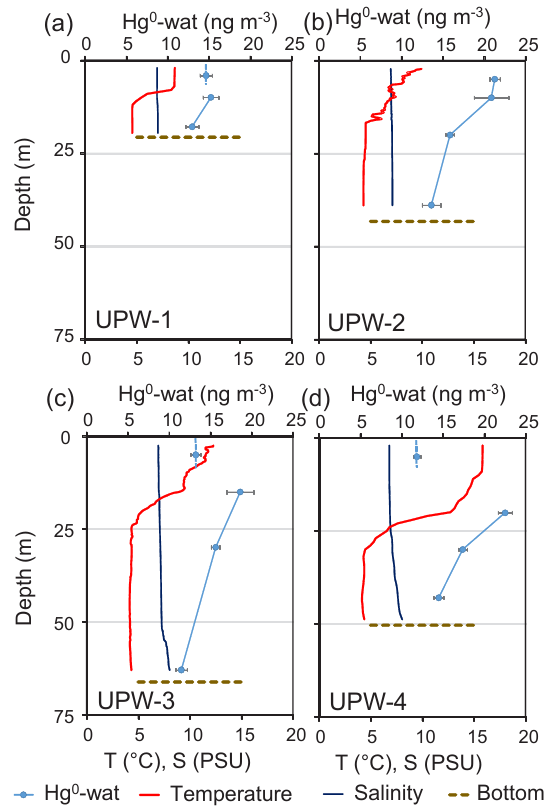
Figure 6. The vertical profiles of Hg 0 wat , temperature ( T ), and salin- ity ( S ) of an upwelling area close to Øland Island (Sweden) mea- sured in 2015. The four stations UPW-1, UPW-2, UPW-3, and UPW-4 were separated by 2, 1, and 6 nautical miles,